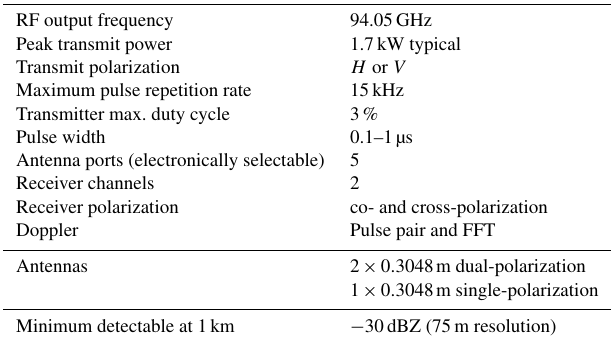
Table 1. The NRC airborne W-band radar